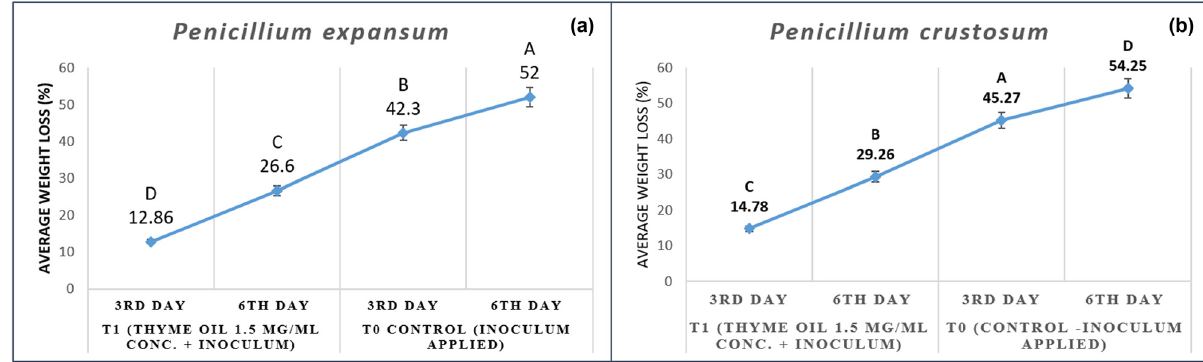
Figure 8: ( a and b ) Average weight loss ( AWL ) assessment of thyme oil against Penicillium